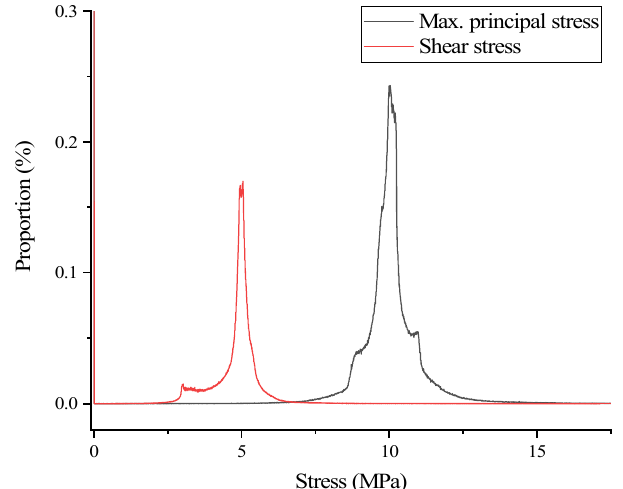
Figure 17. Stress state in mineral regions under a load of 10.19 MPa: ( a ) shear stress ( b ) maximum principal stress.